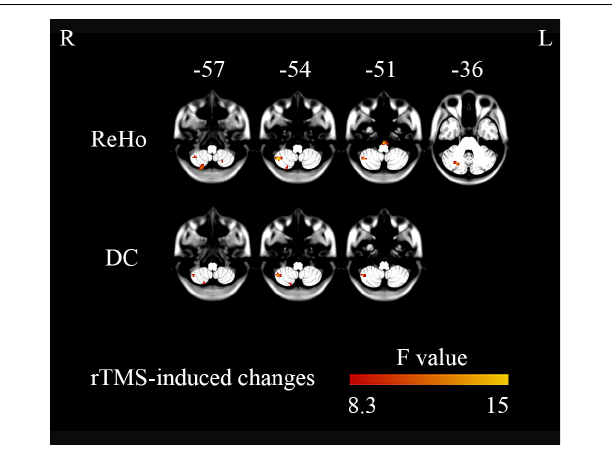
FIGURE 2 | Three-level (1 Hz/low frequency, 10 Hz/high frequency, and sham) one-way ANOVA on changes in brain activity (post- minus pre-rTMS). The right cerebellum showed significant differences between the three stimulation conditions (GRF correction, single voxel p < 0.001, cluster level p < 0.05).